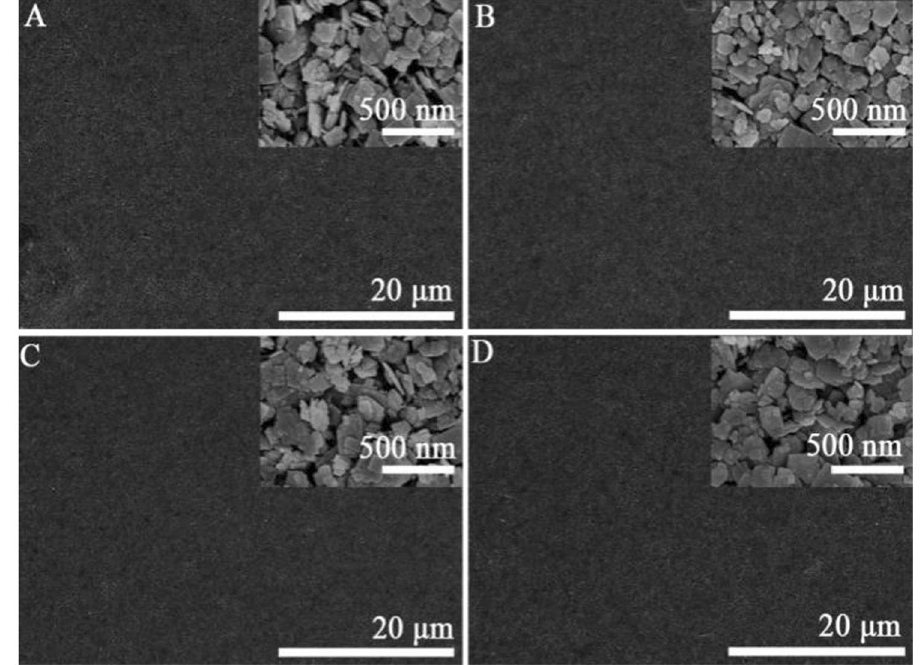
Figure 1. SEM images of WO 3 ( A ), 2RGO/WO 3 ( B ), WO 3 -3P ( C ) and 2RGO/WO 3 -3P ( D ).